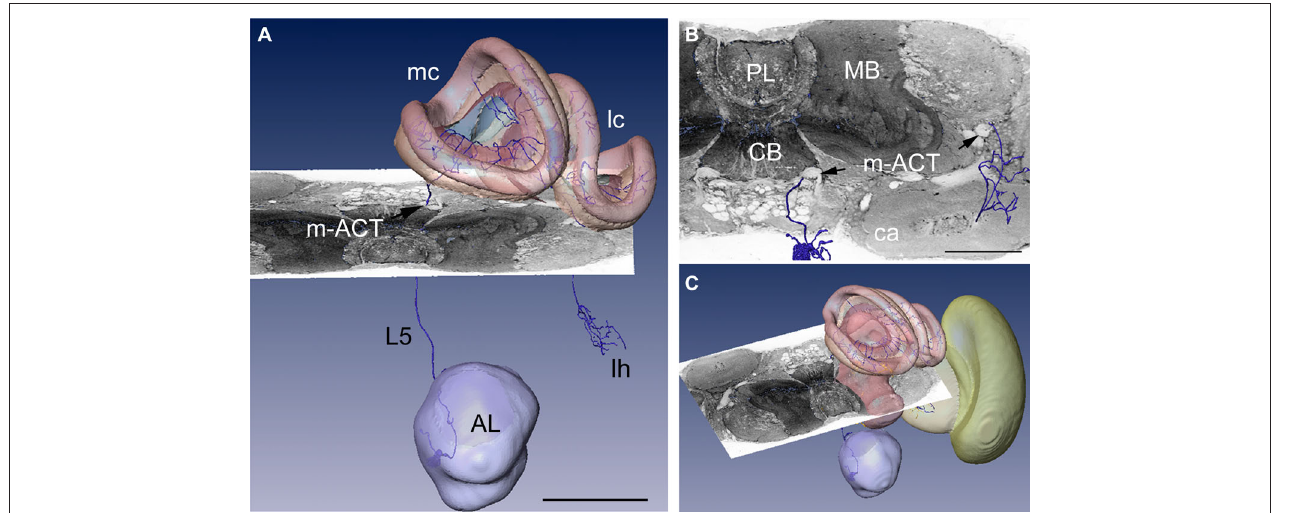
section as the ascending and descending protocerebral part (m-ACT, black arrows). The spatial locations of the two registrations demonstrate the spatial accuracy of fitting neuronal data into the HSB. (C) The histological ethyl gallate section is located at around 300 μm from the calycal surface (horizontal plane). Scale: 200 μm, CB: central body, MB: mushroom body, PL: protocerebral